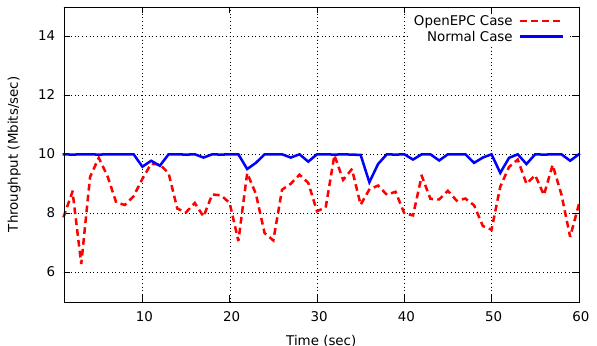
Figure 10. UE throughput for UDP traffic where bandwidth is limited to 10